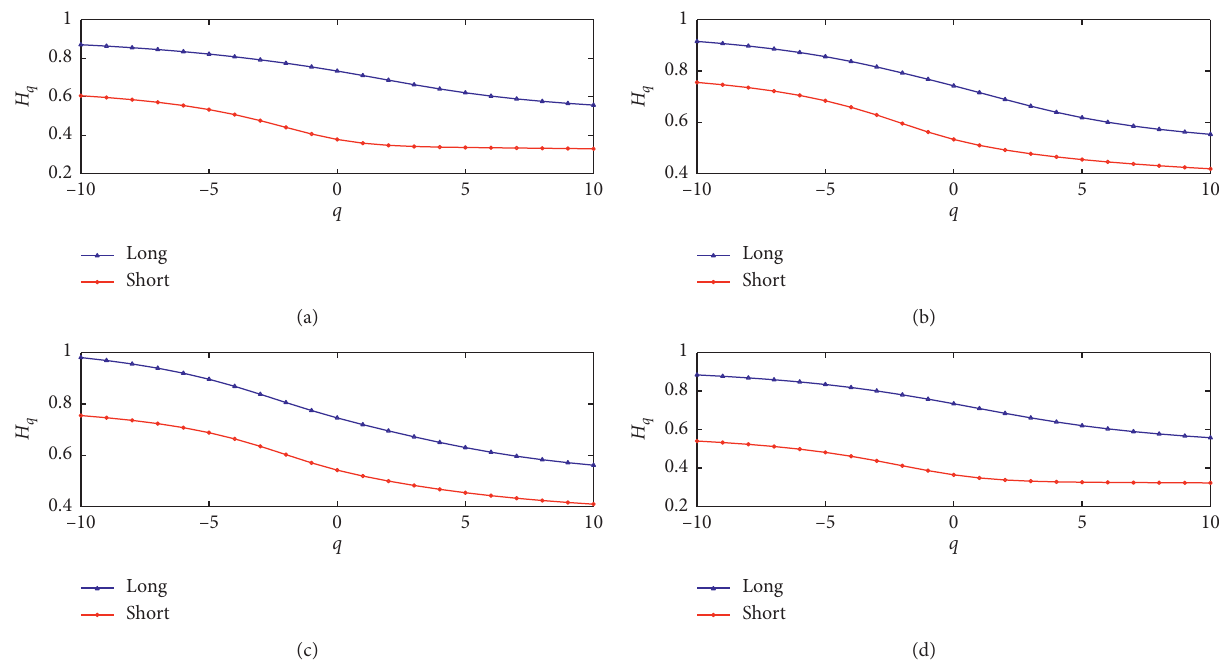
Figure 12: Short and long scaling exponents for Chinese stock market volume and market participation willingness. (a) SME-YSI. (b) SSE50-YSI. (c) CSI300-YSI. (d) GEM-YSI.